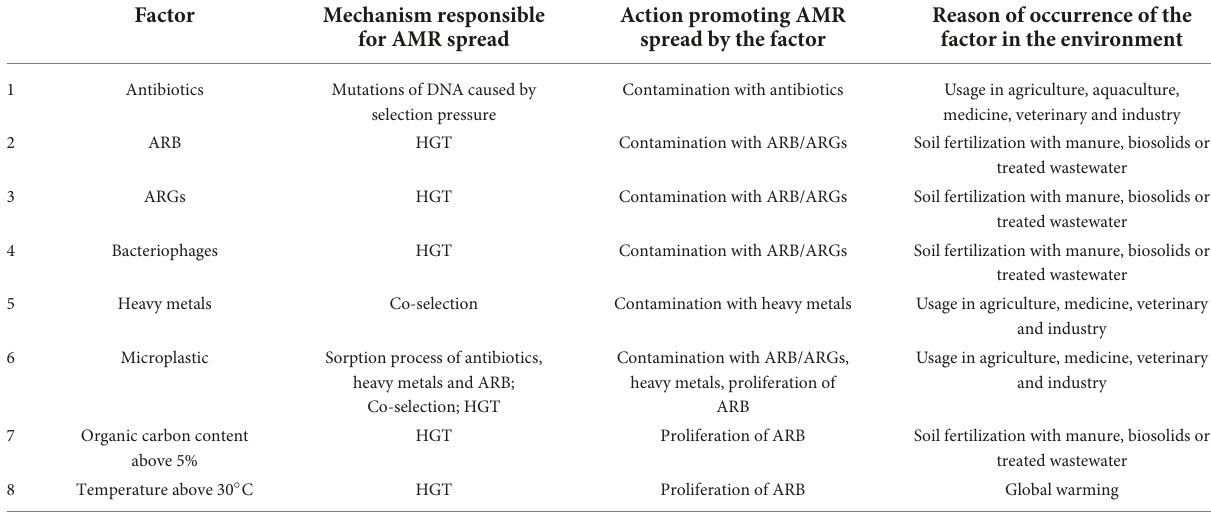
TABLE 1 Factors that promote AMR